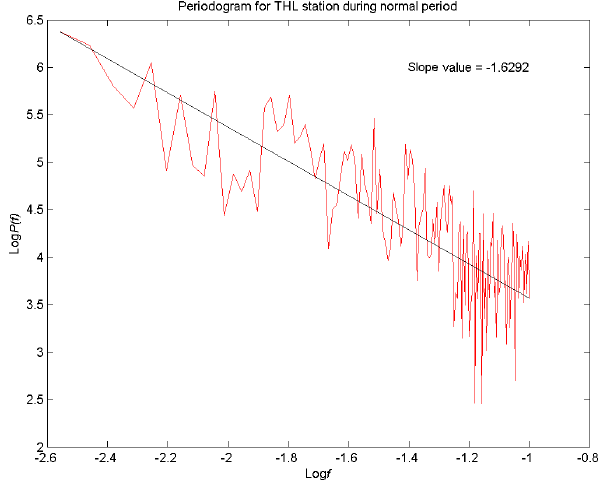
Figure 5. An example figure for power spectral density on 03 February 2011 at station